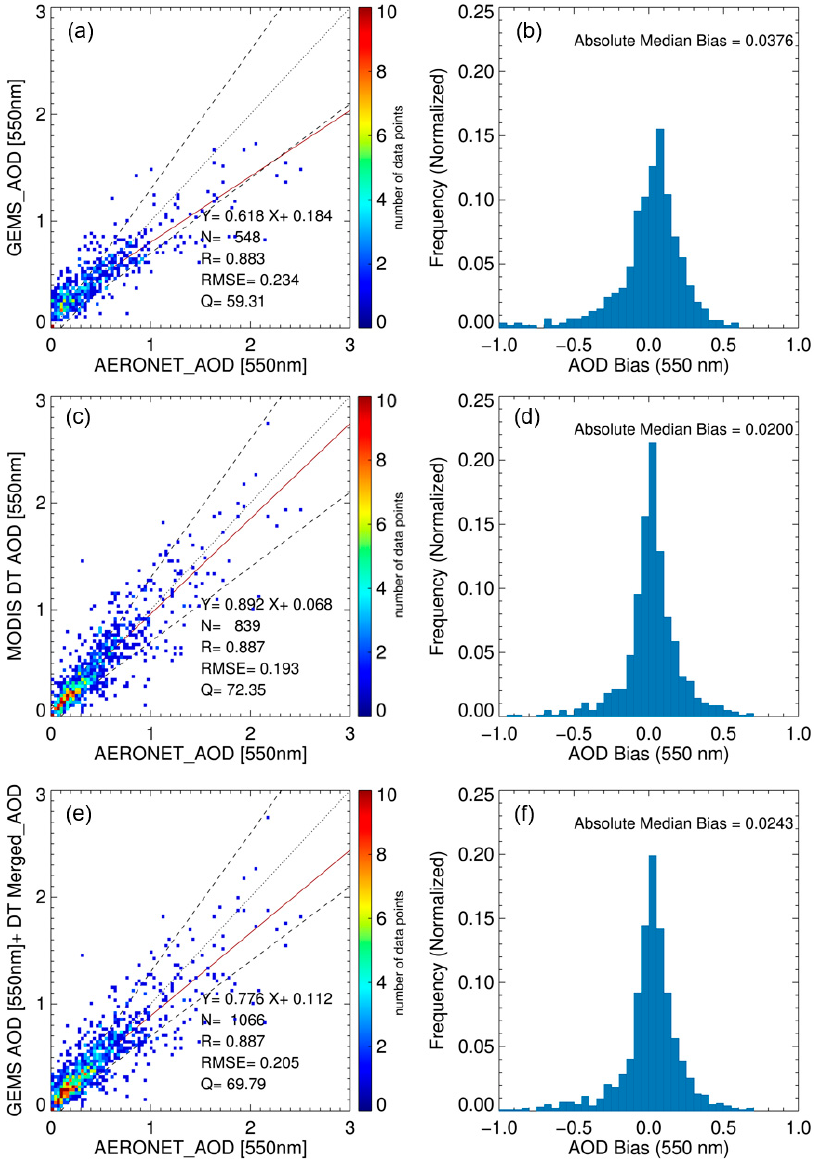
Figure 10. ( a ) Validation results for GEMS AOD (using L1B of OMI as a proxy), 2006. ( b ) Normalized frequency histogram of AOD bias corresponding to results ( a ). ( c ) Validation results for MODIS DT AOD, 2006. ( d ) Normalized frequency histogram of AOD bias corresponding to results ( c ). ( e ) Validation of fused AOD products, 2006. ( f ) Normalized frequency histogram of AOD bias corresponding to the results ( e ). Dotted and dashed lines in ( a , c , e ) are 1:1 and expected AOD error (30% or 0.1; Ahn et al. [65]) lines. The red line indicates the linear fitting line of validation results. The corresponding slope ( 𝐴 ) and offset ( 𝐵 ) for the red line are presented in each figure in 𝑦 = 𝐴𝑥 + 𝐵 format.